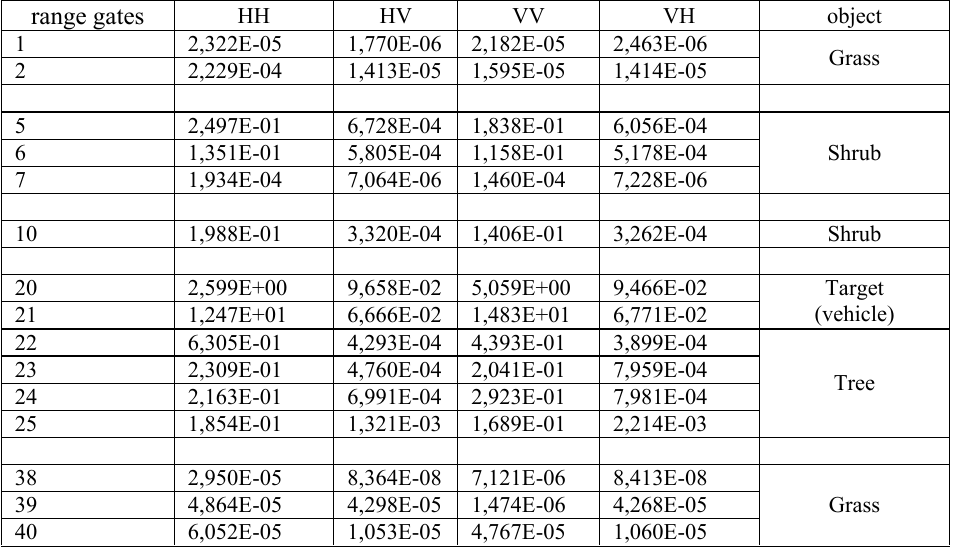
Table 1. The results of the calculation of the RCS values in the scene with the target. range gates